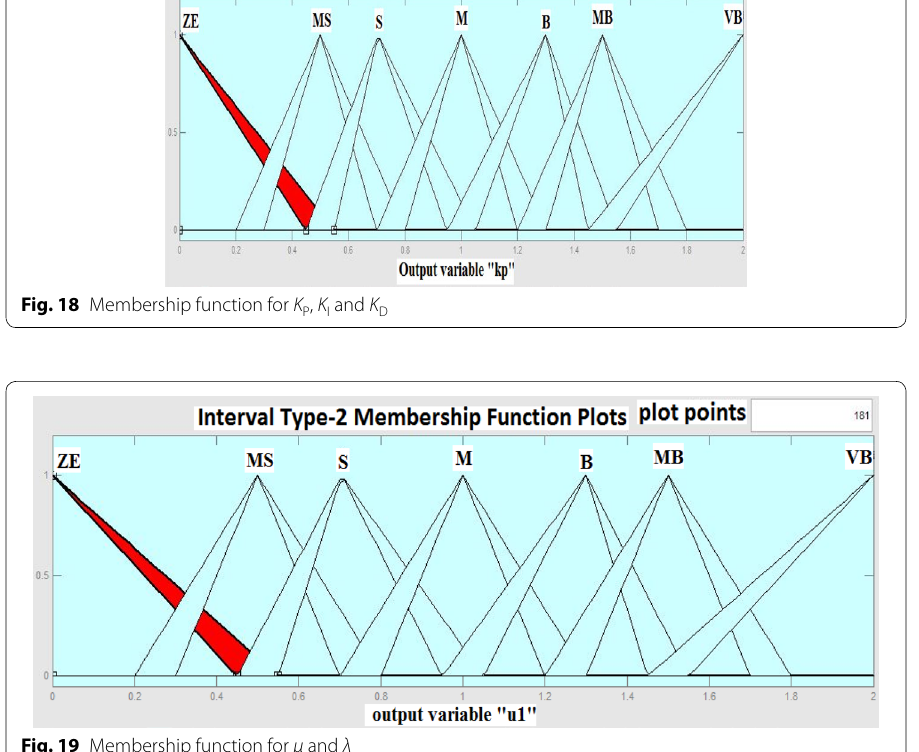
Fig. 19 Membership function for μ and λ